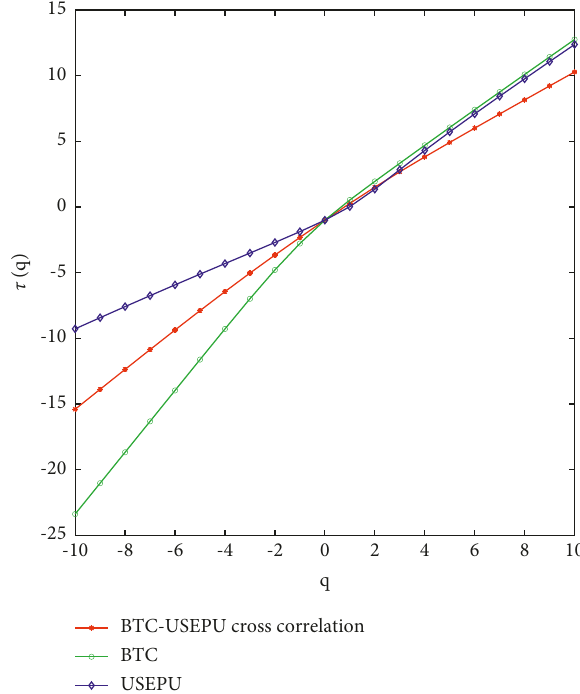
Figure 6: R´enyi exponent of τ ( q ) versus q for BTC and USEPU cross-correlation, the correlation within BTC, and the correlation within USEPU.